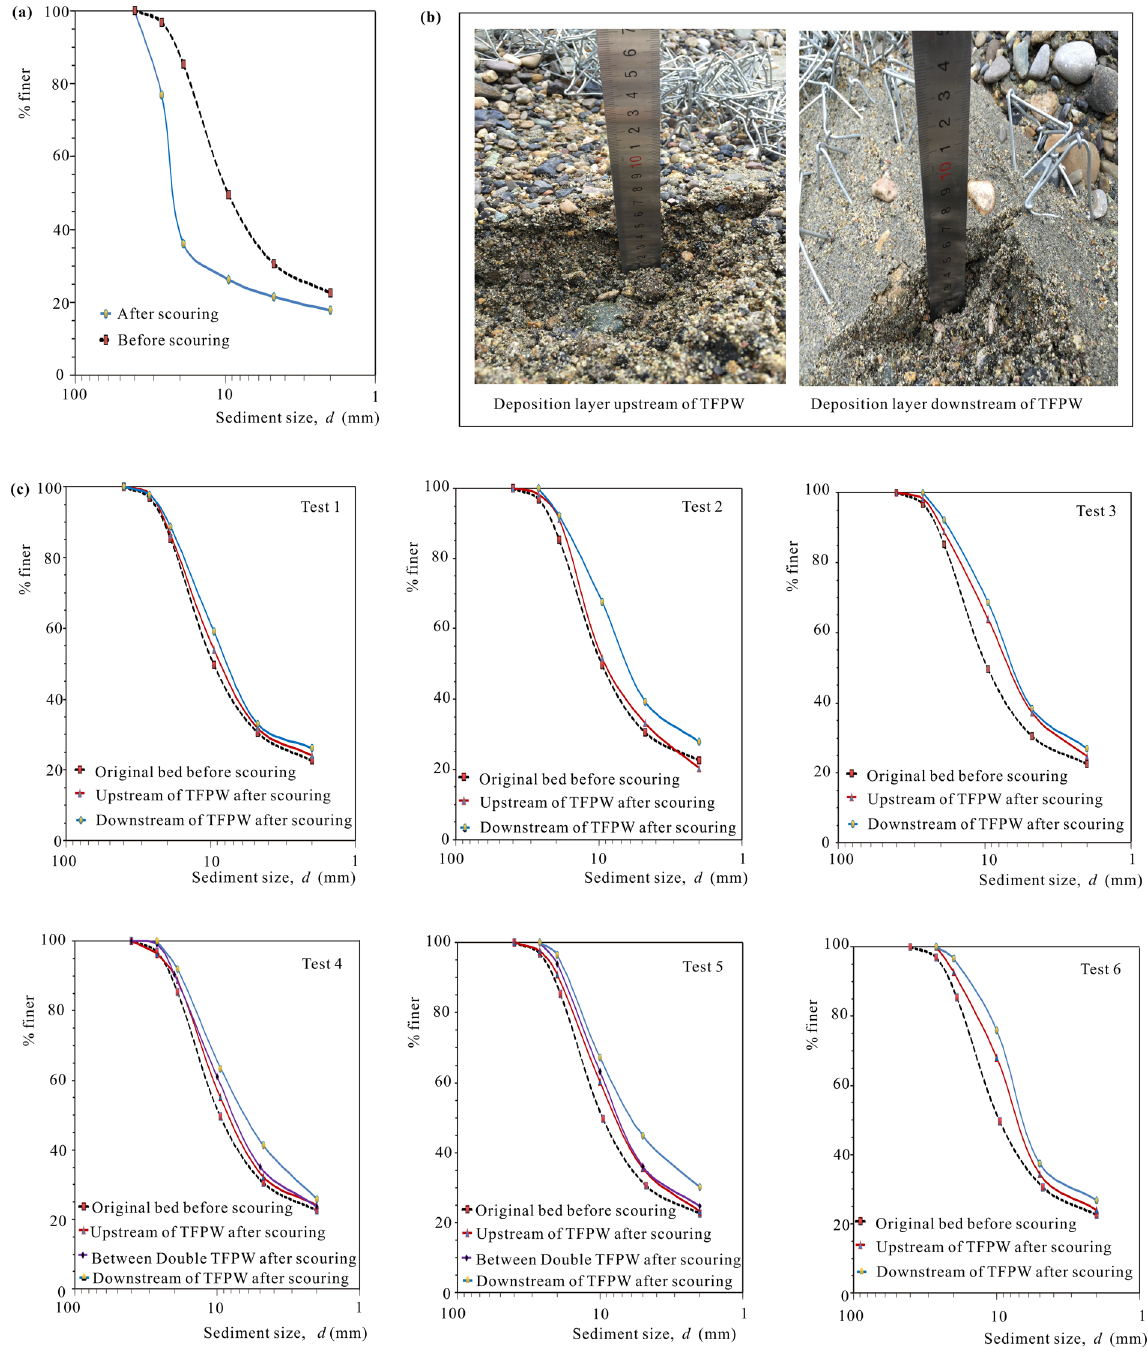
Figure 5. Variation of bed material gradation composition: ( a ) particle size distribution curve of bed materials without any bed protection structures; ( b ) photos of typical deposition layers around TFPW in Test 2 and ( c ) particle size distribution curves of deposition layers under the protection of different